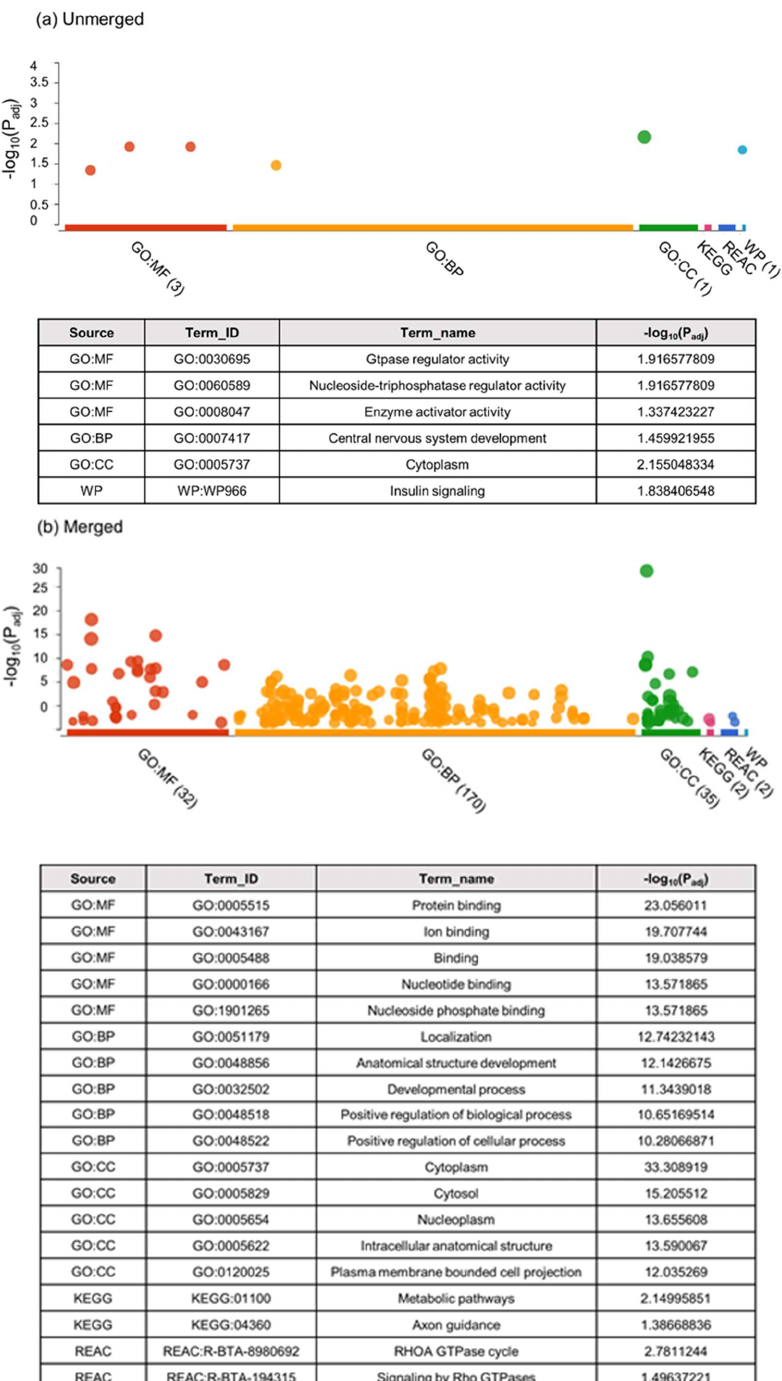
Figure 8. Functional enrichment analysis with g:Profiler of DMRs obtained by segmenting the genome in hypermethylated and hypomethylated domains for two treatments (stimulated and non- stimulated animals). Manhattan plot of g:Profiler enrichment results obtained for unmerged ( a ) and merged ( b ) conditions. GO (Molecular Function – MF, red colour; Biological Process – BP, orange colour; and Cellular Component – CC, green colour), KEGG (pink colour), Reactome (navy blue colour), and WikiPathways (light blue colour) databases were used for the analysis. Only terms with a p value < 0.05 are shown in the graph. The table below shows the most representative terms for each analysis group (where applicable), and the statistical value for each term is indicated by the −Log 10 ( p value).